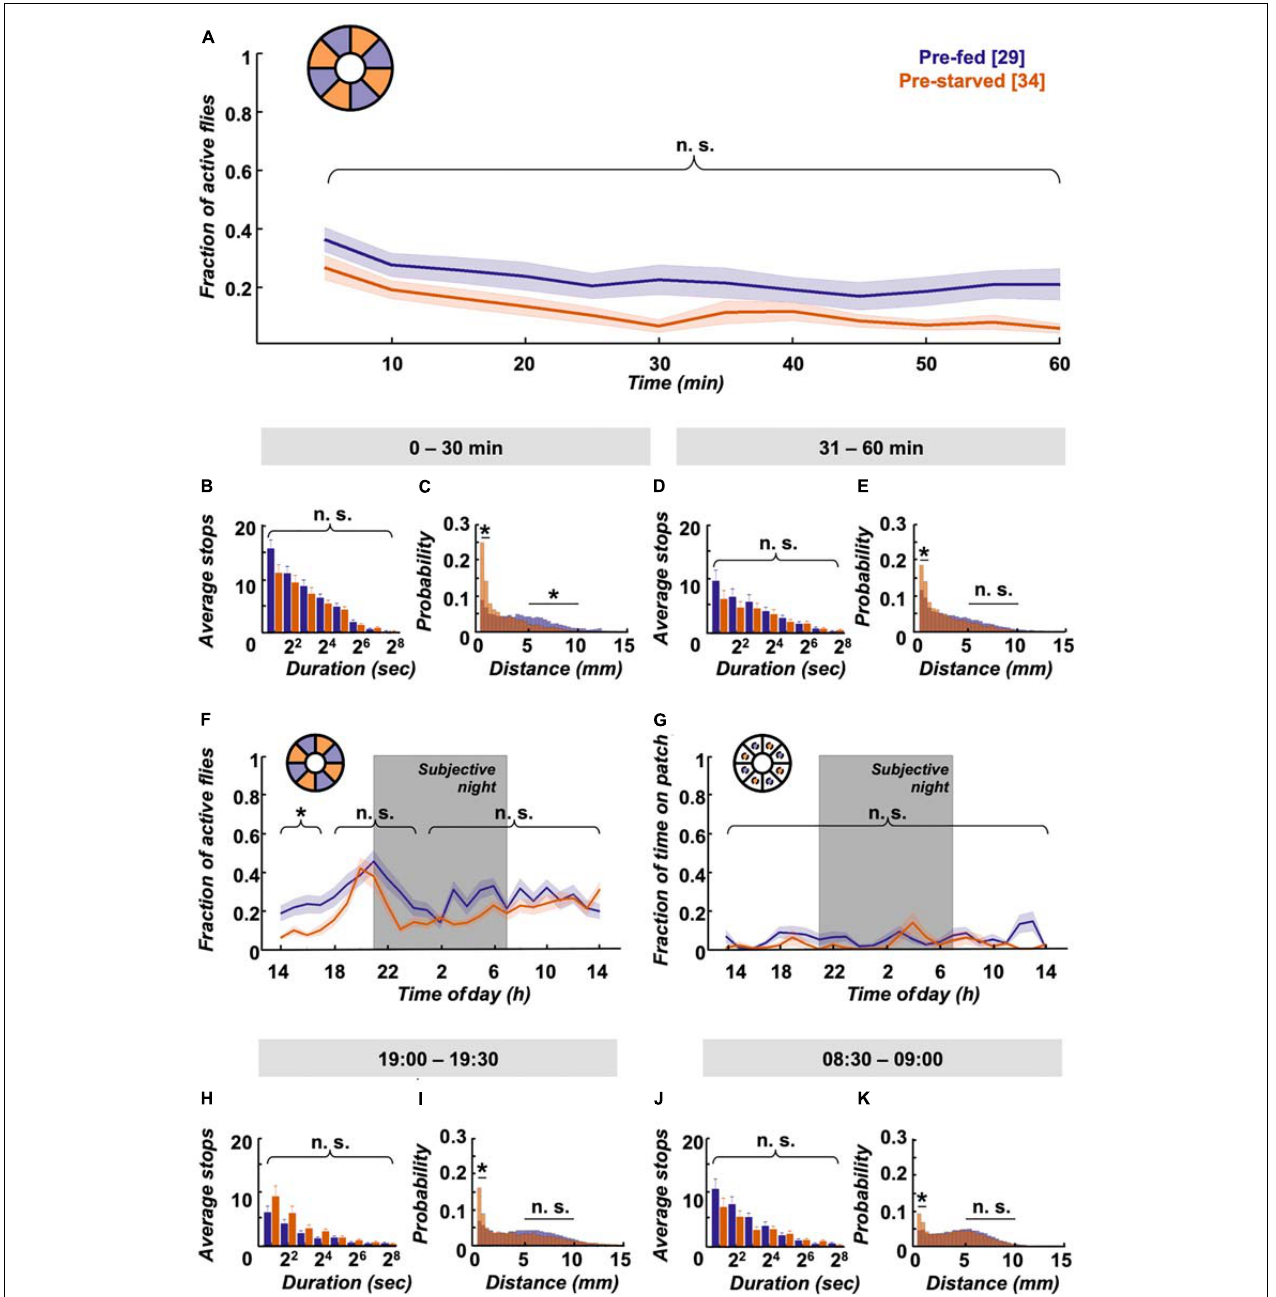
FIGURE 6 | Omnipresent food provision equalises activity levels but not speed. (A) Pre-starved (orange, n = 27) and pre-fed flies (deep purple, n = 34) show no significant difference in activity across the first hour on a homogenous sucrose-covered arena (inset schematic), (B) together with no significant differences observed for shorter stops (2–7 s). X -axis tick labels indicate duration of stops with a log2 scale, where 2 1 = 2–3 s, 2 2 = 4–7 s, and so on. (C) However, pre-starved flies did show higher frequency of short feeding-related walks (0–2 mm) in the first 30 min than those of pre-fed flies, while pre-fed flies showed a significantly higher frequency of longer distance walks (5–10 mm). (D) There was no significant difference observed again in the next 30 min for shorter stops (2–7 s) between the two fly groups, but (E) pre-starved flies continued to show significantly increased short-distance moves as compared to pre-fed flies. (F) Pre-starved flies show comparable activity levels to pre-fed flies, including during the evening activity peak, with no significant difference observed across the remaining 24 h. (G) Location probability within virtual food patch-sized areas revealed no significant difference in place preference across 24 h for both pre-starved and pre-fed flies. (H) During the 19:00–19:30 time window, both groups showed equal number of short stops (2–7 s), with (I) consistent higher frequency of short-distance walks seen in pre-starved flies than pre-fed flies. (J) No significant difference in short stops (2–7s) was observed during the 08:30–09:00 time window the next morning across both groups, (K) and again a significant difference in short-distance moves. Data indicates higher walking speed in pre-fed flies as compared to pre-starved flies. *Indicate significance levels following Mann–Whitney U-tests (alpha = 0.05), n.s. = not significant. Horizontal lines indicate significance levels between pre-fed and pre-starved flies from a single group. Curly braces represent identical significance levels between pre-fed and pre-starved from multiple groups. N values are given in brackets.